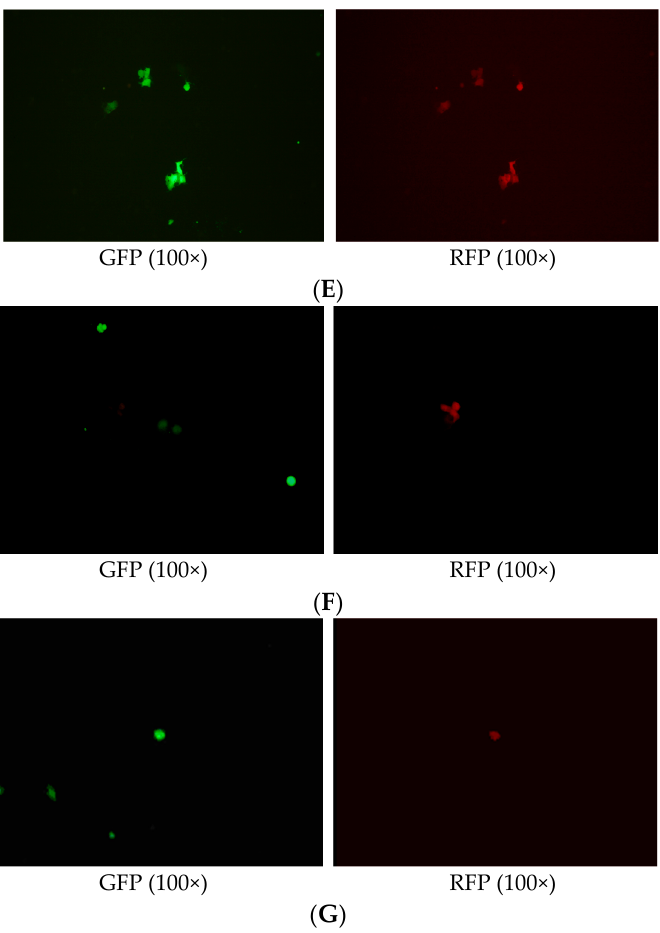
Figure 5. ( A ) Transfection efficiency of the conjugates of PU-PEI 600 -maleimide/DNA complexes at various diSH/PU-PEI 600 -maleimide-DNA molar ratios. Results are presented as mean ± SD ( n = 3); ( B , C ) The dual DNA transfection of the conjugates of two different PU-PEI 600 -maleimid/DNA complexes after thio conjugation and 100× and 400× magnification, respectively; ( D ) Transfection of a mix of two different PU-PEI 600 -maleimide/DNA complexes without dithiol conjugaion (100×); ( E ) The dual DNA transfection of the four-fold diluted conjugates of two different PU-PEI 600 -maleimid/DNA complexes; ( F ) Transfection of a four-fold diluted mix of two different PU-PEI 600 -maleimide/DNA complexes without dithiol conjugaion; ( G ) Transfection of PU-PEI 600 -maleimide in complexation with a mix of two DNA after four-fold dilution without dithiol conjugaion.